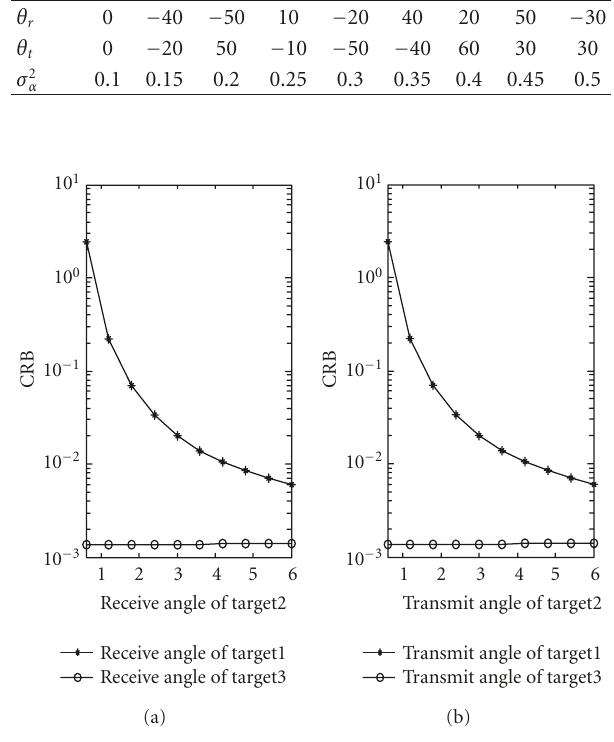
Figure 6: CRB of Target 1 and Target 3 as a function of Target 2’s angles, where Target 1 locates at θ t 1 = 0 ◦ , θ r 1 = 0 ◦ , Target 3 locates at θ t 3 = 50 ◦ , θ r 3 = 50 ◦ , σ 2